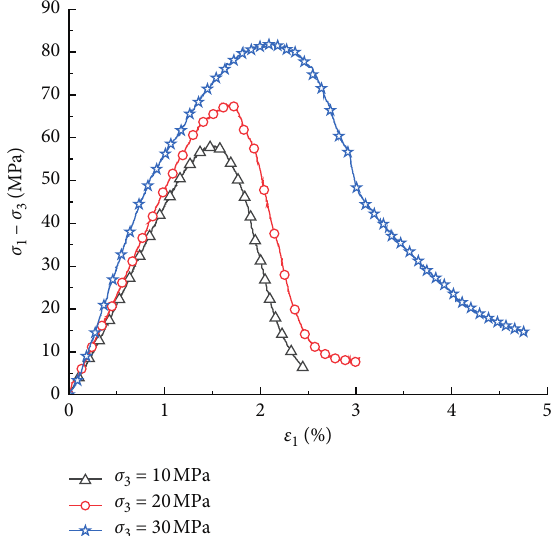
Figure 6: Stress-strain curves of sandstone with different confining pressures ( − 10 ° C).